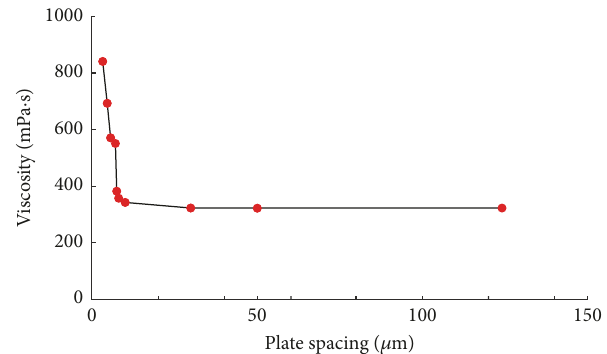
Figure 3: Relationship between fluid viscosity and energy attenua- tion rate and 𝑇 2